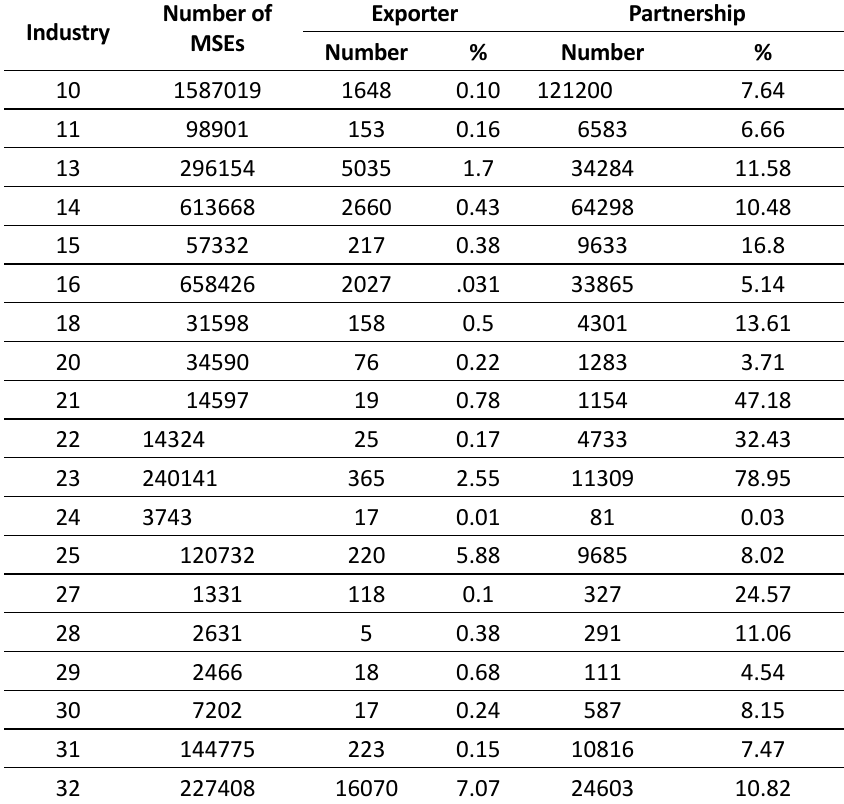
Table 4: Number and Percentage of MSEs involved in Export by Group of Industry and Part- nership, 2019 Number of Industry